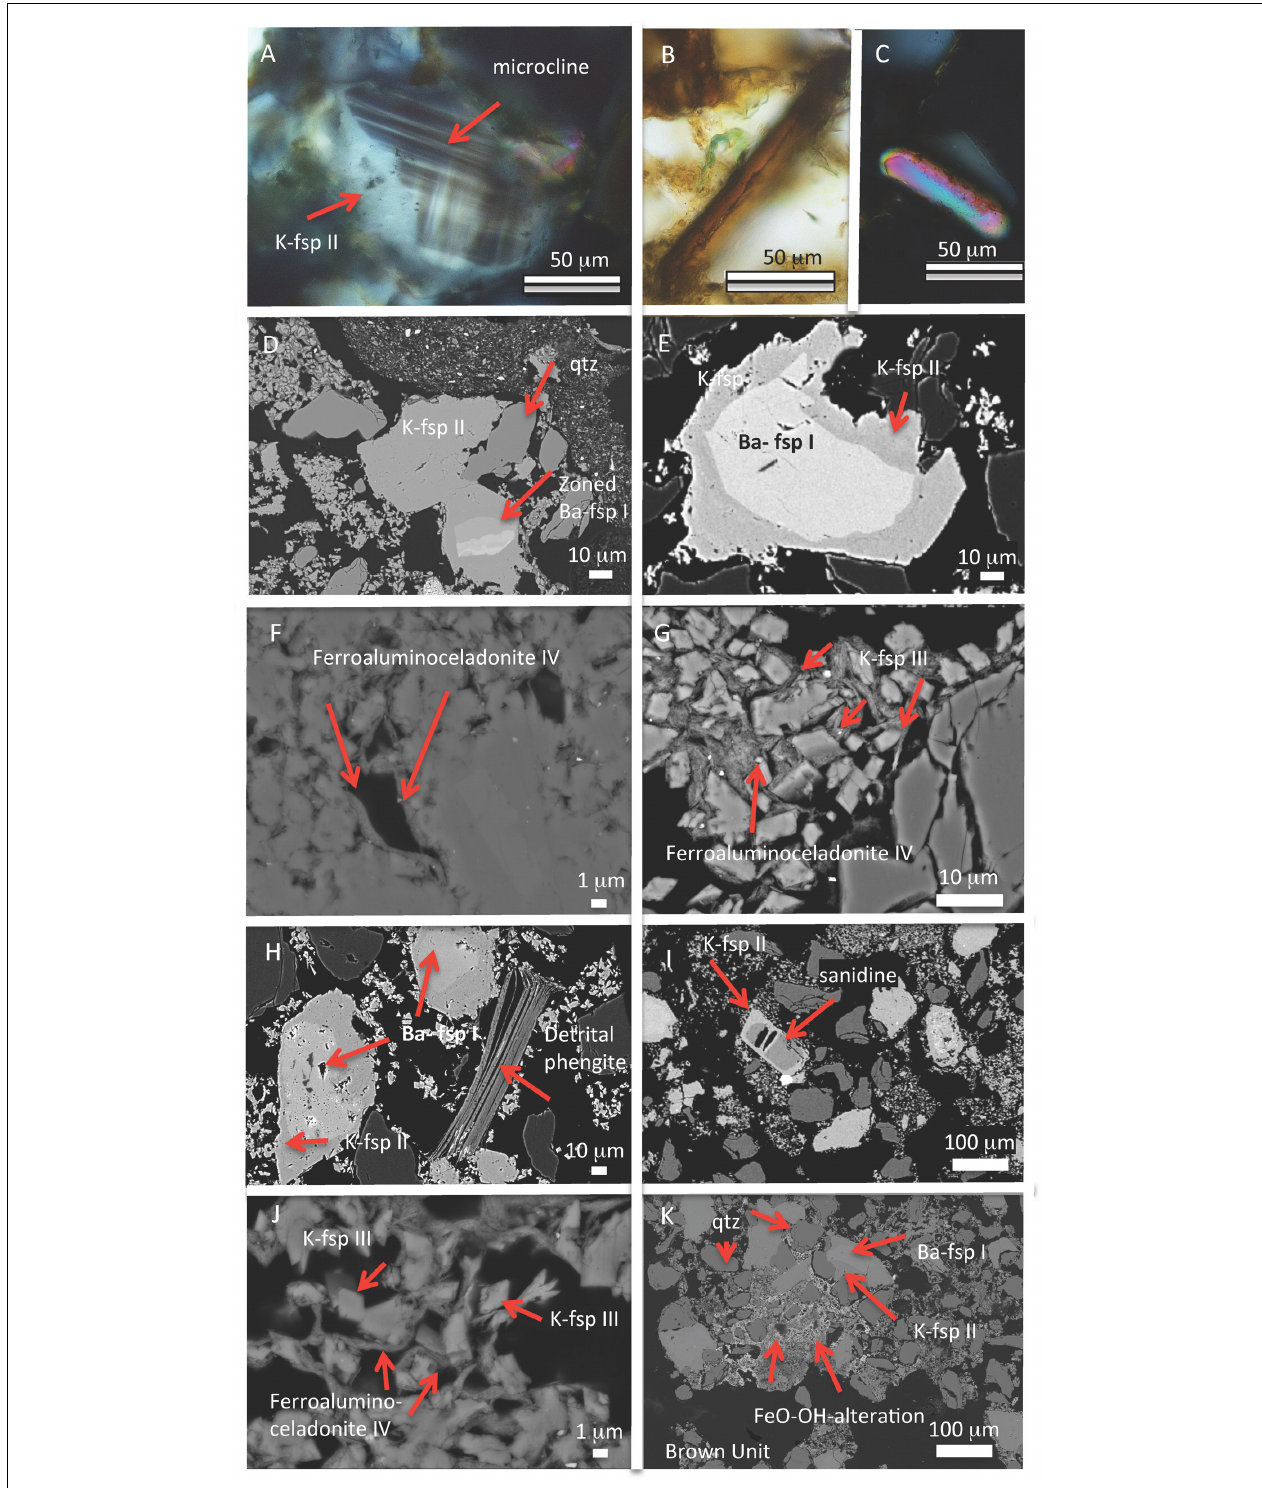
FIGURE 8 | Petrography of the analyzed rocks. (A–C) Microscope images. (A) Microcline rimmed by K-feldspar generation GII, XPL (cross-polarized light); (B) rutile, PPL (plane-polarized light); (C) zircon, XPL. (D–K) back scattered images. (D) Zoned Ba-K-feldspar I rimmed by K-feldspar II; (E) zoned K-feldspar with Ba-rich center I and rim ksp II; (F) ferroaluminoceladonite IV as the last phase to coat earlier grown minerals; (G) ferroaluminoceladonite IV coats last euhedral K-feldspar phase III; (H) detrital phengite and the three feldspar generations I to III; (I) sanidine with up to 5% Na 2 O rimmed by K-feldspar; (J) last euhedral K-feldspar phase III surrounded by ferroaluminoceladonite IV; (K) brown unit with Fe-O-OH alteration and zoned Ba-K-feldspar.